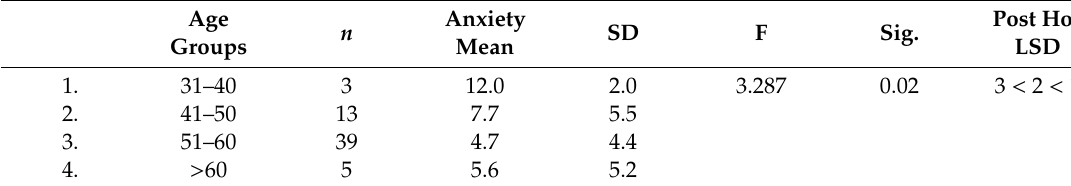
Table 3. One-way analysis of variance of Anxiety by Age ( n = 60).